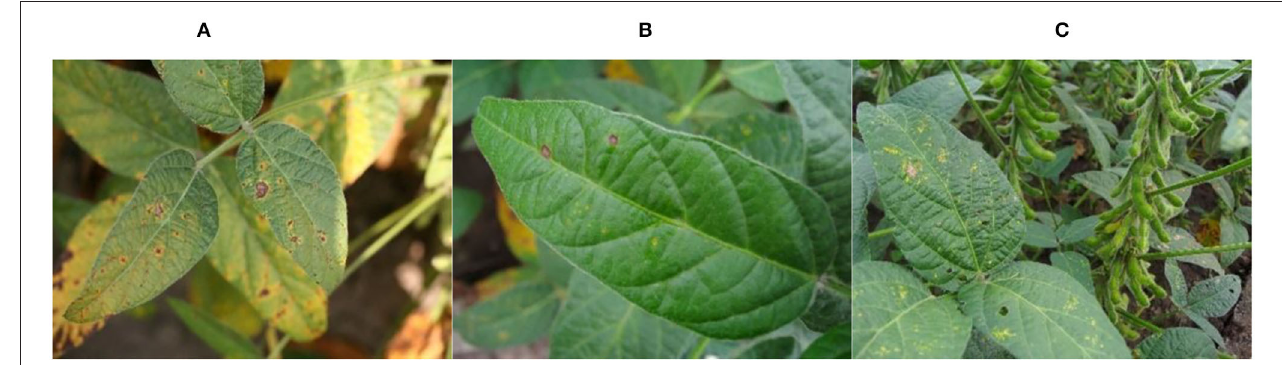
FIGURE 2 | Images of the soybean diseases. (A) Soybean brown leaf spot; (B) soybean frogeye leaf spot; (C) soybean phyllosticta leaf spot.